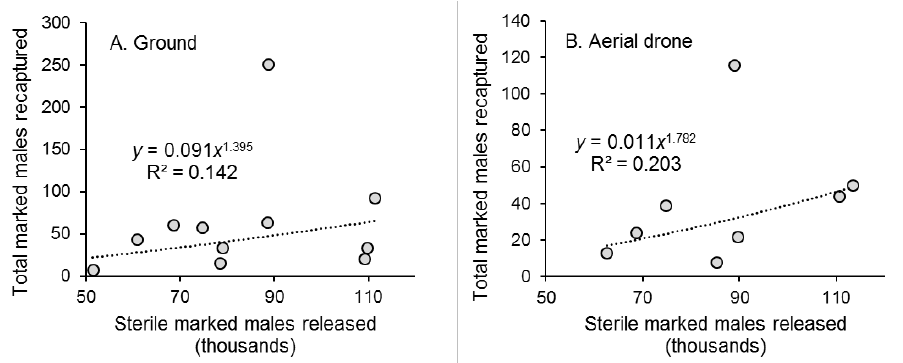
Figure 3. Correlation between the weekly number of marked sterile males of Aedes aegypti released (in thousands) by the ( A ) ground release method and ( B ) aerial drone method and the total number of marked males recaptured each week during 11 weeks of ground releases and 8 weeks of aerial releases in Hidalgo village, southern Mexico. Each graph shows the correlation equation and coefficient of determination (R 2 ).